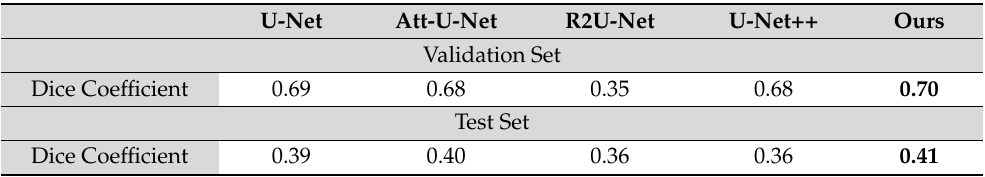
Table 1. The test results of different segmentation models without C3S in the training